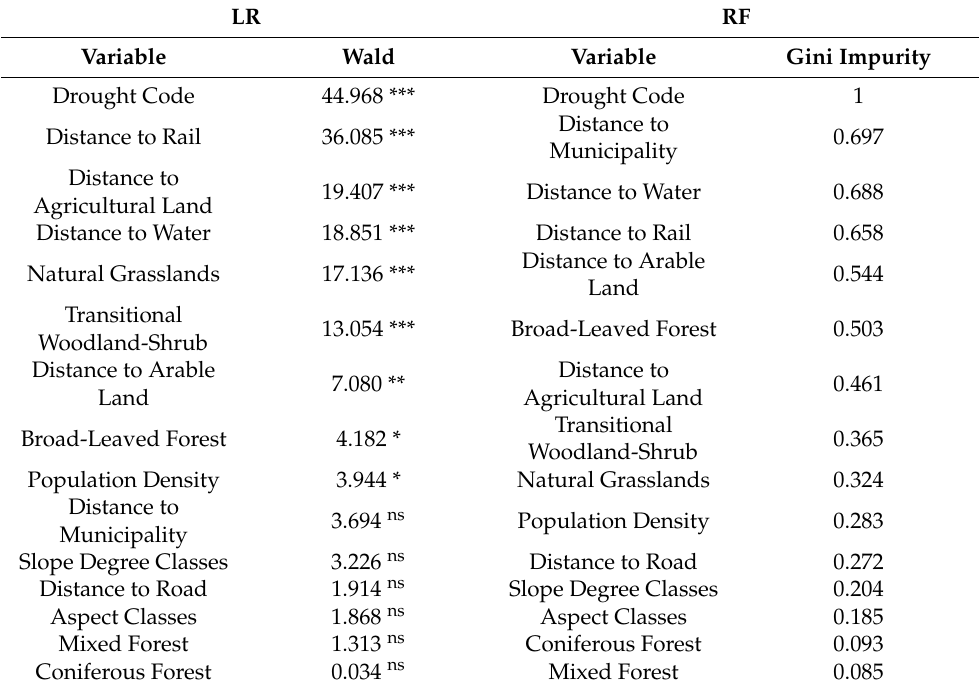
Table 2. Explanatory variable importance evaluation based on Wald statistics for linear regression (LR) and Gini impurity for random forest (RF) models.